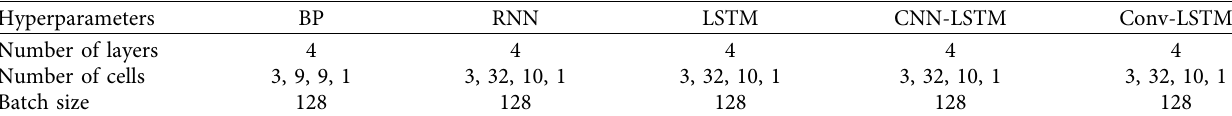
Figure 8: Architecture of ConvLSTM CF model. Table 2: The hyperparameters of ANN CF models.